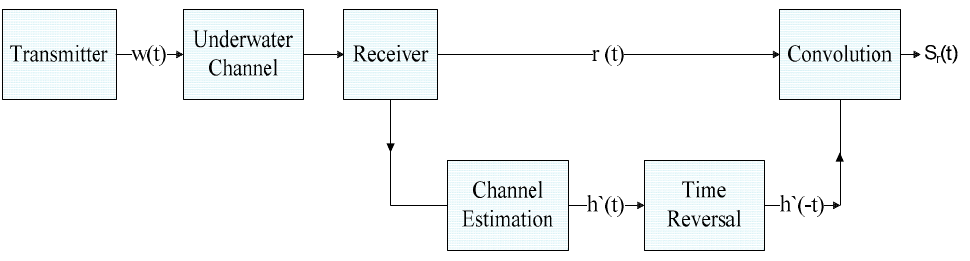
Figure 9. Frame work of Virtual Time Reversal Mirror method.